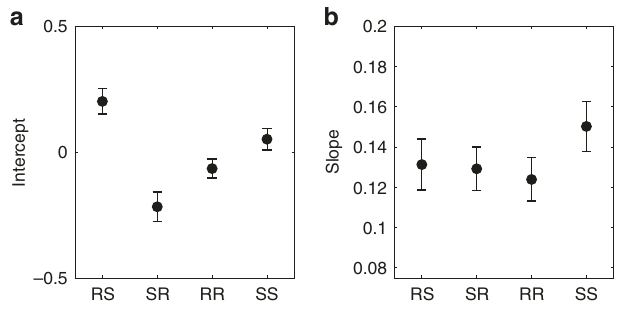
Fig. 2 Probit regression results. a Intercept and b slope of choice probability function fi t for each condition using maximum likelihood estimation. Error bars are cross-subject standard